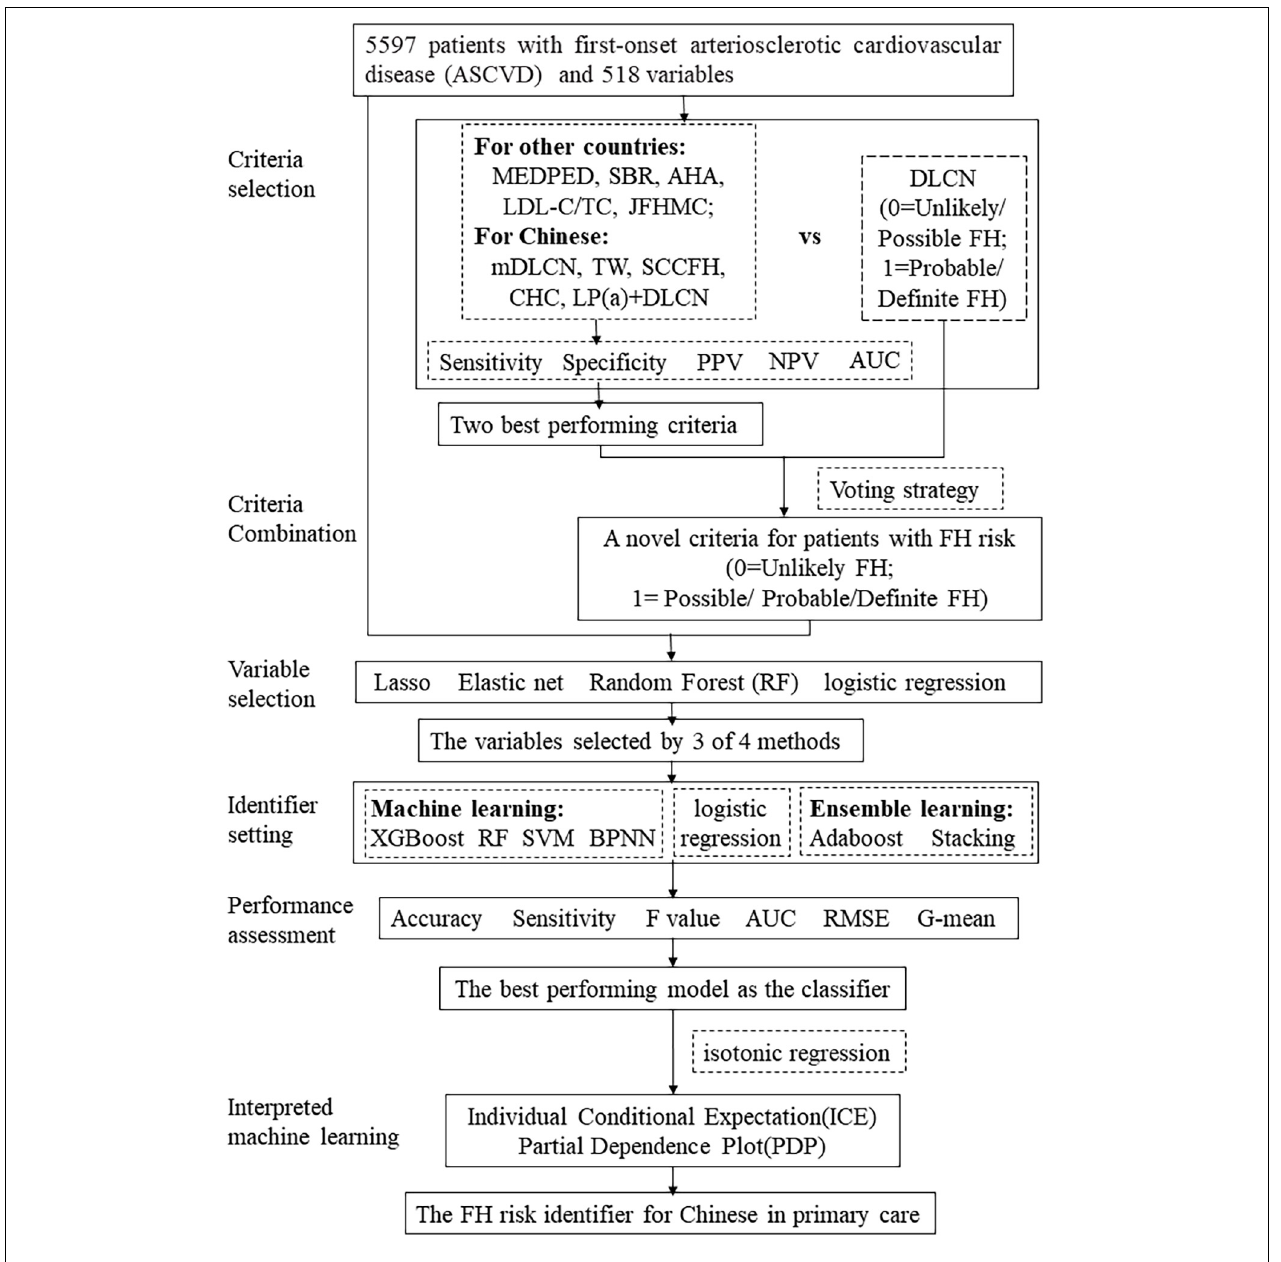
FIGURE 2 | The roadmap of identifier